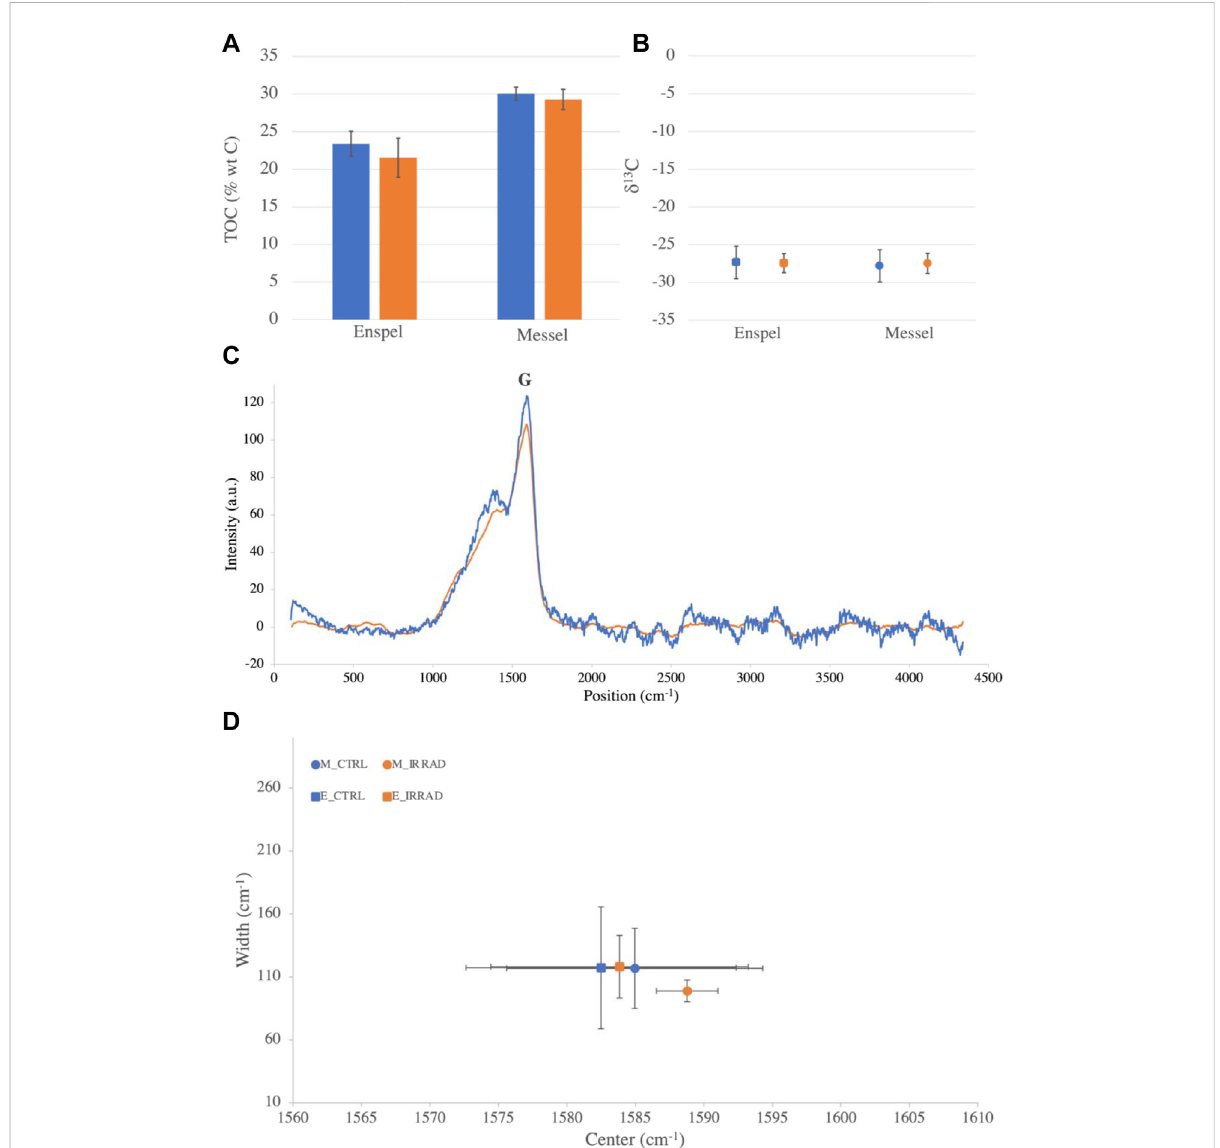
FIGURE 1 Changes of TOC, bulk stable carbon isotopes ratios and Raman G-band. (A) Enspel and Messel shales TOC before (blue) and after (orange) an equivalent of 15 Myr of radiation exposure on Mars. (B) d 13 C isotope ratios in Enspel (squares) and in Messel (circles) before (blue) and after (orange) irradiation. (C) Raman spectra of Enspel G band before (blue) and after (orange) irradiation. (D) Plot of G band parameters (center position vs. width) for Enspel (squares) and Messel (Circles) before (blue) and after (orange) irradiation. Smaller error bars for irradiated Messel shale (orange) are due to a smaller sample size during Raman data acquisition. For all fi gures, error bars take into account instrumental error and natural variation of organic content in the